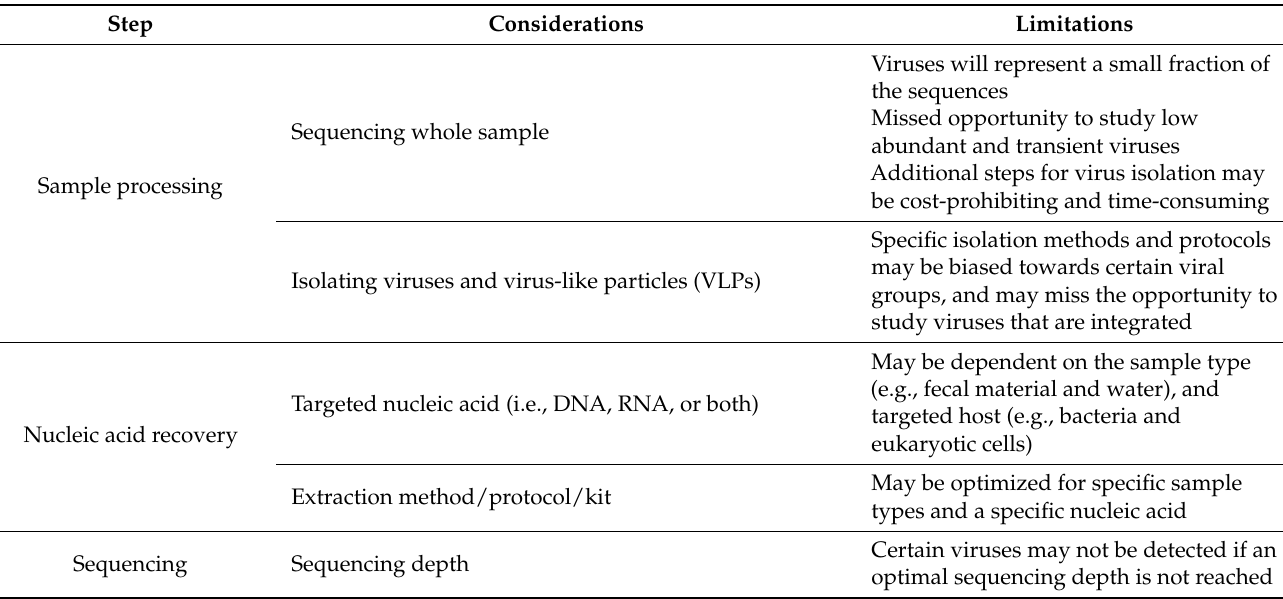
Table 2. Considerations and limitations of specific steps of a viral metagenomic pipeline.